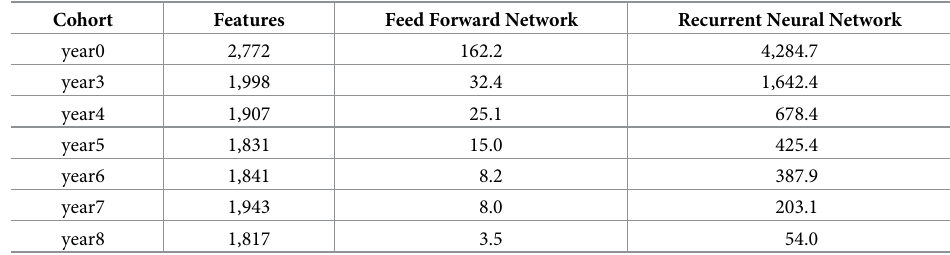
Table 4. Training time in seconds per epoch for feed-forward network and recurrent neural network